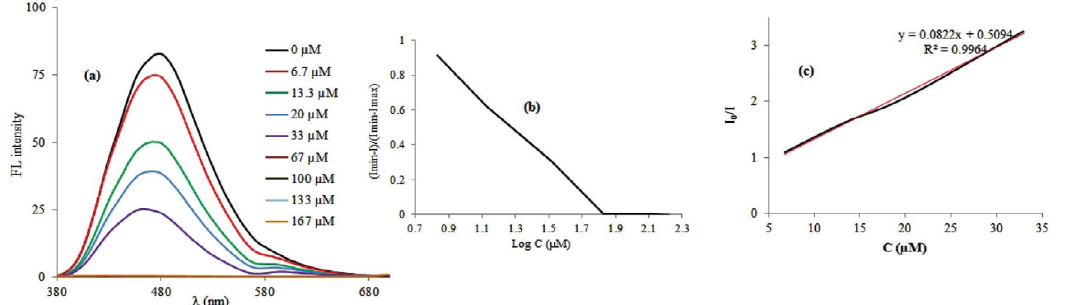
Fig. 8. F luorescence intensity of GOTC upon titration with Fe 2+ (a), the normalized intensity [(I